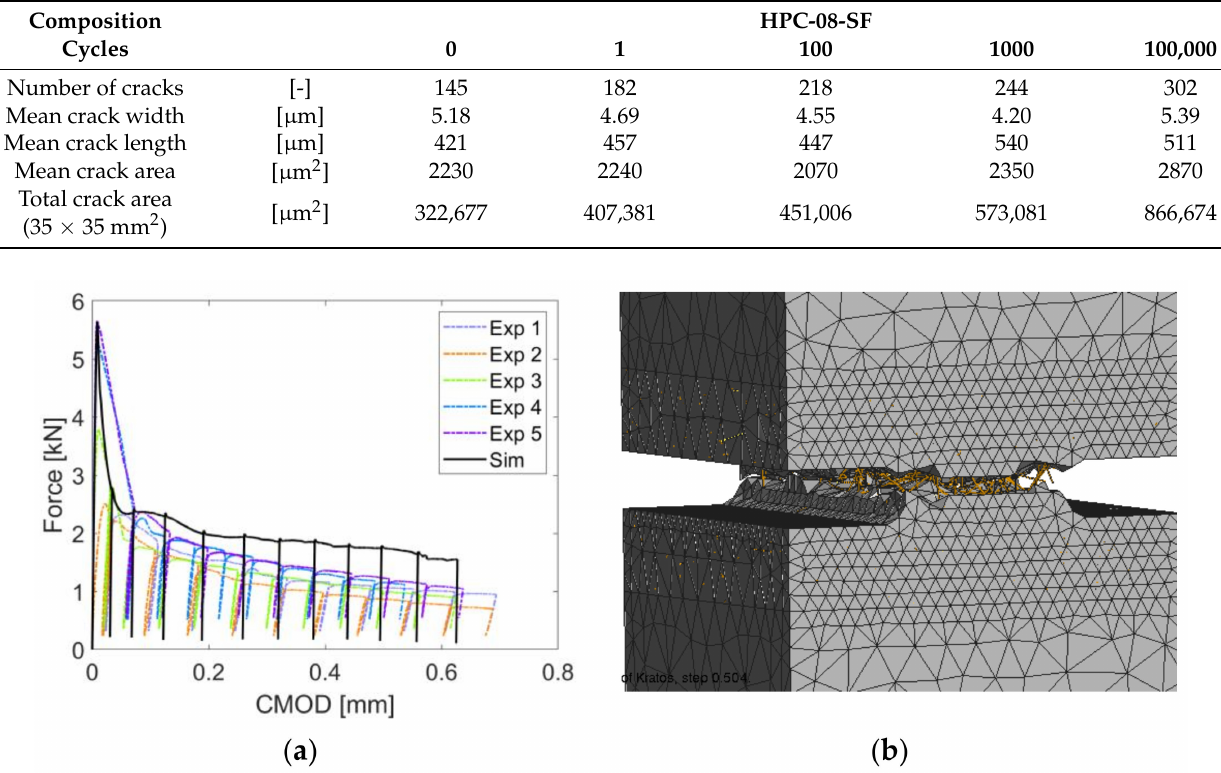
Figure 15. ( a ) Experimentally and numerically obtained force versus crack mouth opening displacement (CMOD) curves; ( b ) Side view of the numerically simulated fiber reinforced notched prismatic